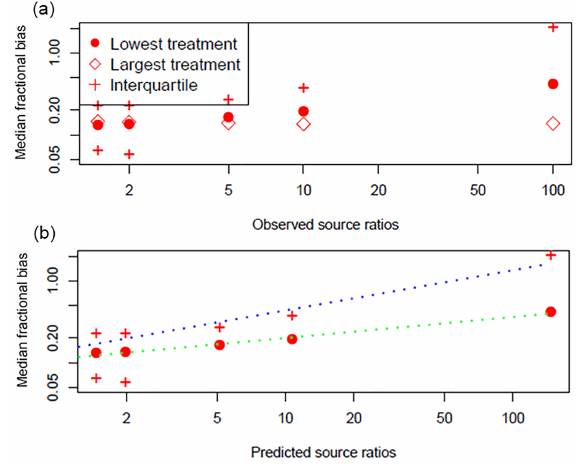
Figure 12. Median fractional bias of cumulated emissions as a func- tion of the ratio of the high-to-low source treatments for a 7-day integration period. (a) Bias as a function of the theoretical source ratios. (b) Bias as a function of the predicted source ratios. Dotted lines show power function regressions on medians (green) and in- terquartiles (blue). Strategies C1 and C3 are pooled together with all runs including sensor heights 0.25 and